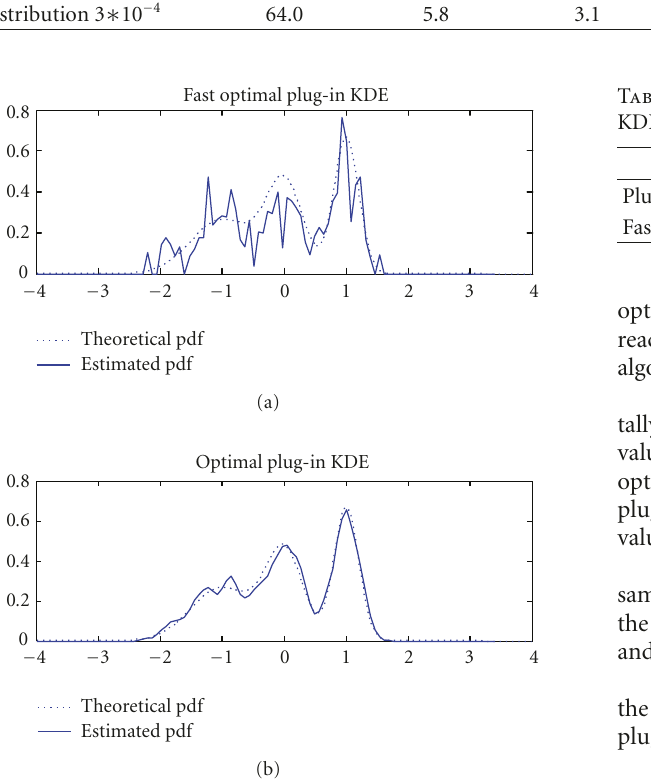
Figure 1: Multimodal pdf estimated using optimal plug-in KDE and fast optimal plug-in KDE (power 6).